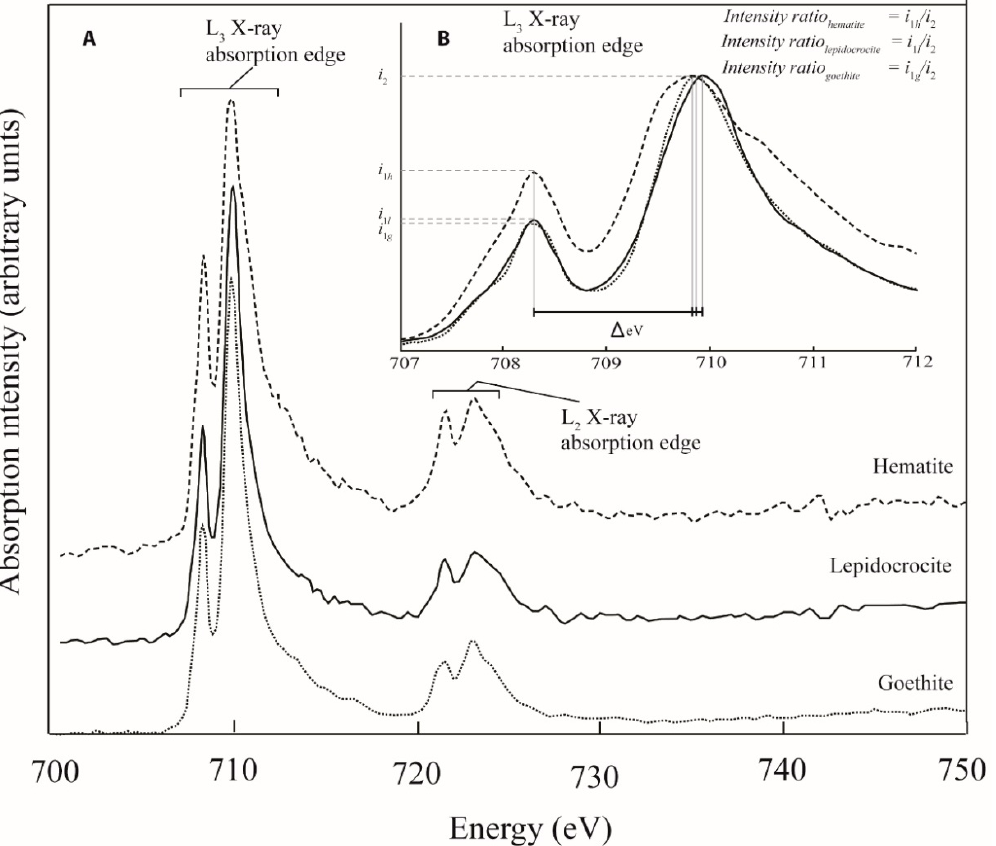
Figure 1. ( A ) The Fe L 2,3 X-ray Absorption Near-Edge Structure (XANES) spectrum for three standard iron oxide minerals (goethite ( α -FeOOH); lepidocrocite ( γ -FeOOH); and hematite ( α -Fe 2 O 3 )) clearly illustrating the peak splitting that occurs in both the L 2 -edge and the L 3 -edge on account of ligand field splittinge ff ects. ( B ) The fine structure of the L 3 -edge region of the spectrum (i.e., the degree of L 3 -edge peak splitting ( ∆ eV) and the intensity ratio ( i ) between the split peaks) reflects the di ff erences in chemistry and mineralogy of the three minerals. These di ff erences can be quantified and represent a useful tool for Fe nanoparticle characterisation (e.g., Figure 2; Reference